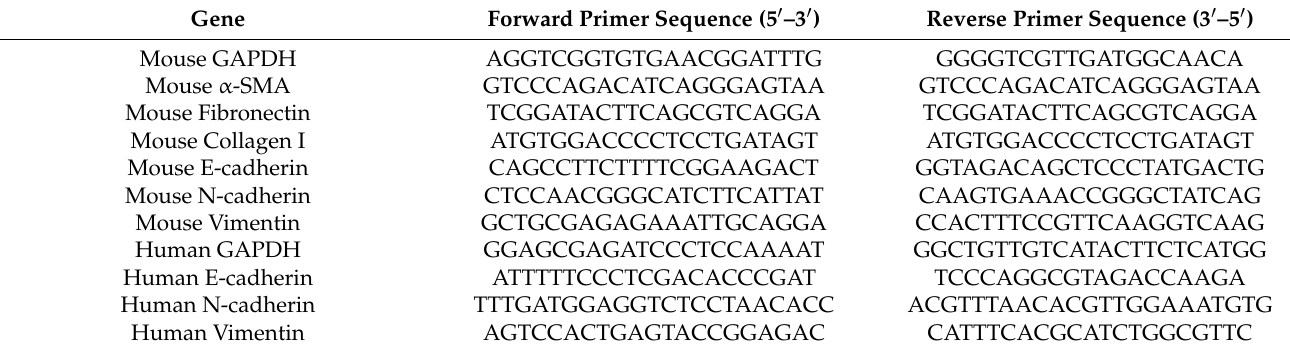
Table 1. Primers sequences for real-time